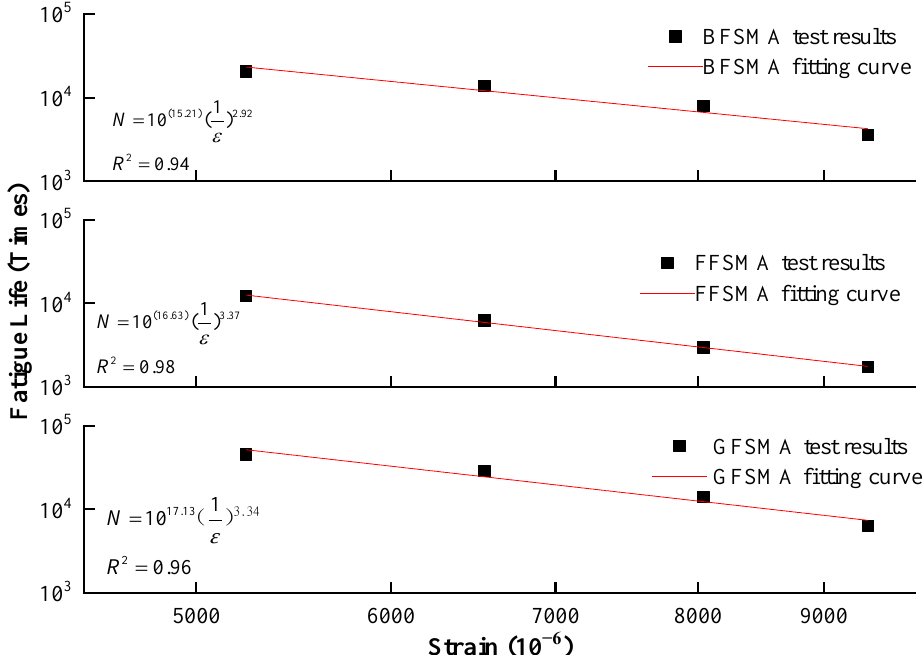
Figure 13. Fitting between strain level and fatigue life.